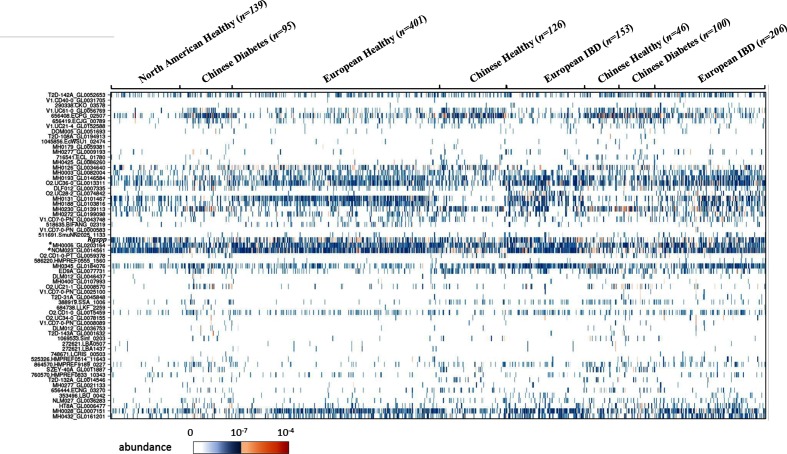
Prevalence and abundance of the human gut GH13_18 gene homologues found in the human gut reference catalogue (1267 individuals from diverse geographical origins and with different health status). Connections between GH13_18 sequences and sequences from the catalogue are indicated in Table S3. The target Rgspp shares, respectively, 97.8 and 98.4 % identities with the sequences MH0006_GL0203164 (*) and NOM023_GL0014561 (*) of the catalogue.